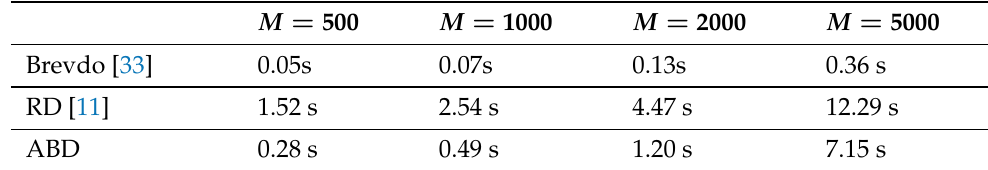
Table 3. Computational cost of the competing approaches for synthetic data analysis. The results have been obtained by averaging over 50 realizations.